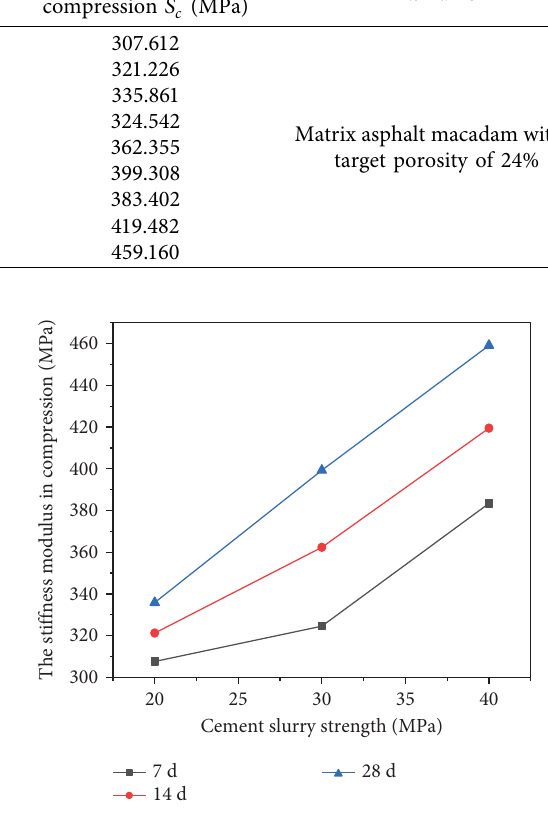
Figure 8: Damaged forms of the specimens. (a) Prismatic specimens before the test. (b) Specimens after the test. Table 16: Uniaxial compressive test data processing results at the same cement slurry strength. Cement slurry